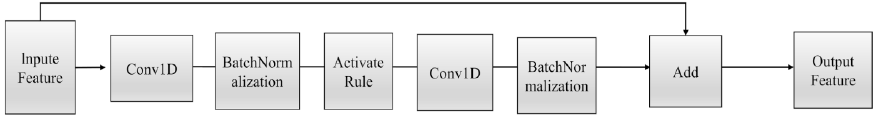
Figure 6. 1D Convolutional network with residual structure.